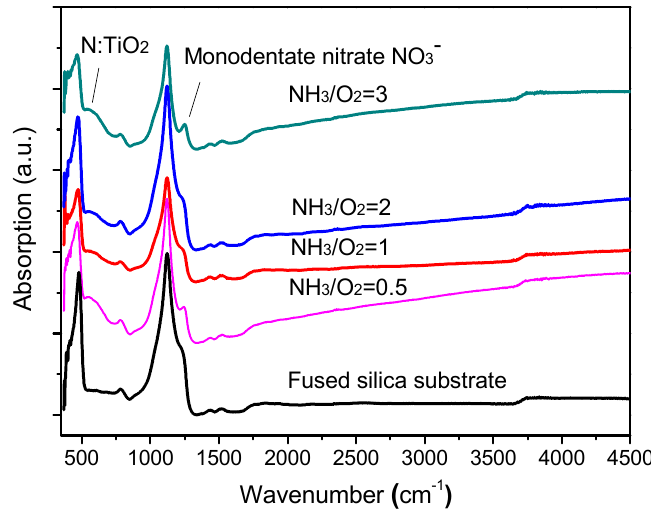
Figure 4. Fourier transform infrared (FTIR) spectra of N-doped TiO 2 films.